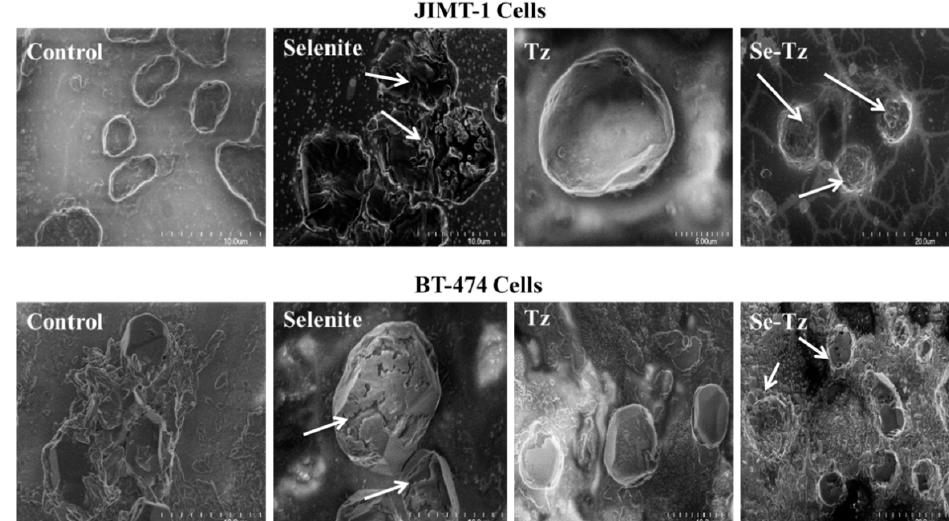
Figure 10. Morphology of control and selenium treated JIMT-1 and BT-474 cells by scanning electron microscopy. Represen- tative control and Se treated cancer cells at 72 h were fixed in 10% buffered formalin on glass cover slips and allowed to air-dry for 4–5 h. SEM images of both the cancer cell lines were taken using a Hitachi Model S-4700 FE-SEM at magnifications of 5–20 µ m after 96 h of selenium